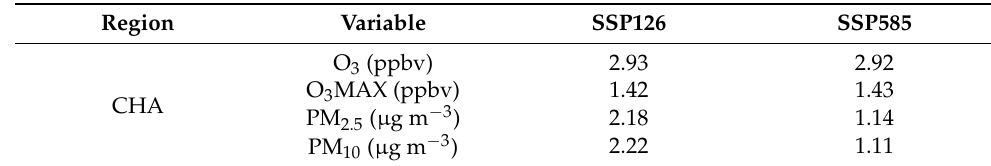
Figure 6. Impact of land-use change on O 3 MAX, PM 2.5 , and PM 10 concentrations under SSP scenarios. Table 4. The ratio of impact of land-use changes on the concentration of O 3 and PM concentrations in summer to the annual average